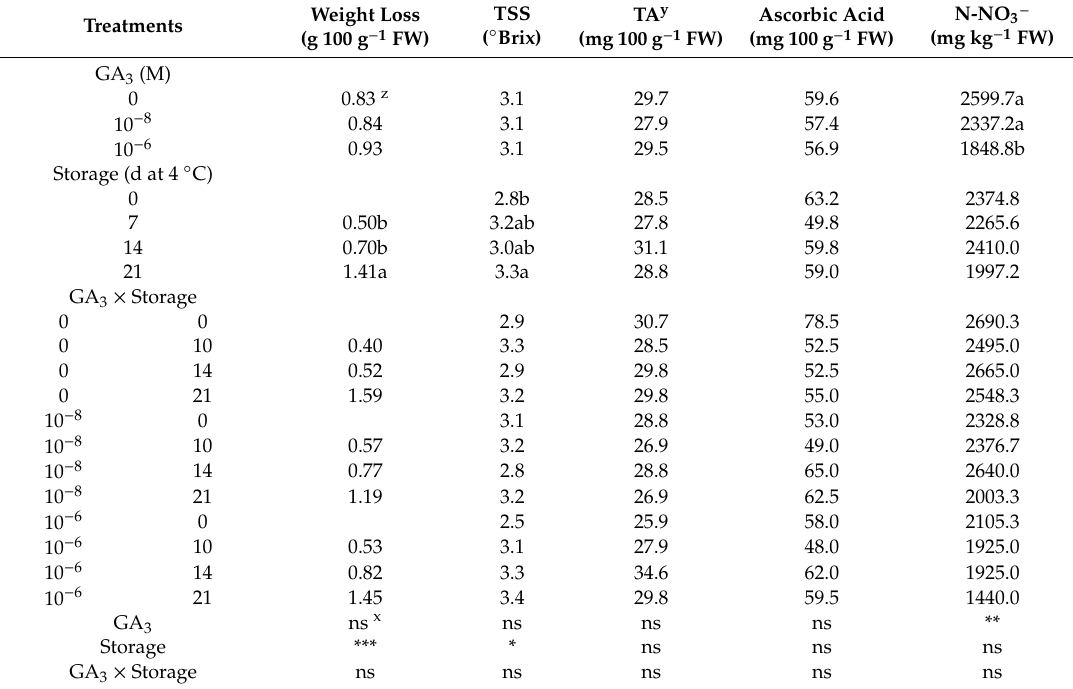
Table 2. E ff ect of GA 3 and storage duration (d) on weight loss, total soluble solids (TSS), titratable acidity (TA), and ascorbic acid and nitrate content of minimally processed leaf lettuce.